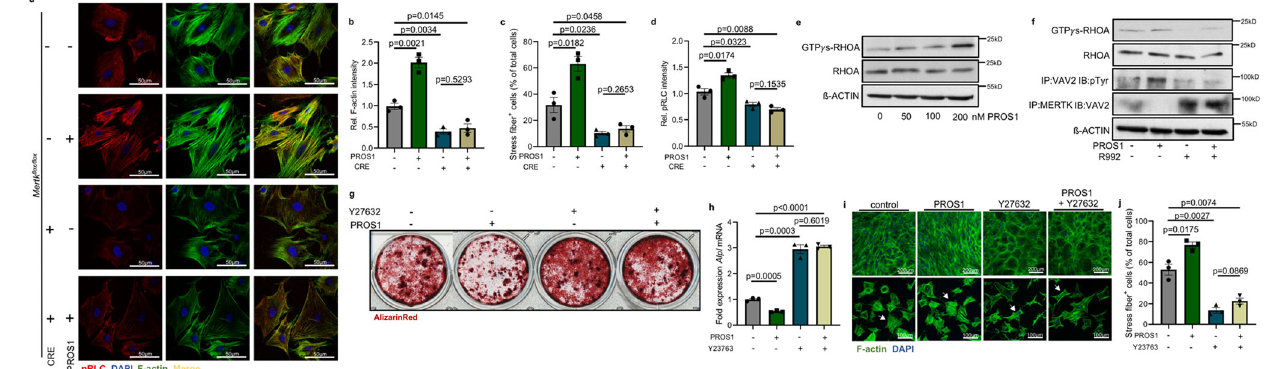
Fig. 2 | Inhibition of bone formation by MERTK is mediated by PROS1-MERTK- VAV2-RHOA-ROCK axis. a – d Confocal imaging of pRLC and F-actin staining of MERTKKOosteoblastsonglasscoverslipstreatedwithTAMreceptorligandPROS1 (100nM) ( a ).F-actin intensity ( n =3,meanof 50 measurements in three fi elds) ( b ), stress fi ber-containing cells ( n =3, mean of 100 measurements in three fi elds) ( c ), and pRLC intensity ( n =3, mean of 50 measurements in three fi elds) ( d ) was quanti fi ed. e Immunoblot of wild-type osteoblasts treated with different con- centrations of PROS1 (0, 50, 100, 200nM) showing activated GTP γ s-bound RHOA, total-RHOA,andß-ACTIN.ß-ACTINrunonaseparategel. f Immunoblotofwild-type osteoblasts treated with PROS1 (100nM) and MERTK-inhibitor R992 (200nM) showing activated GTP γ s-bound RHOA, total-RHOA, phosphorylated VAV2,